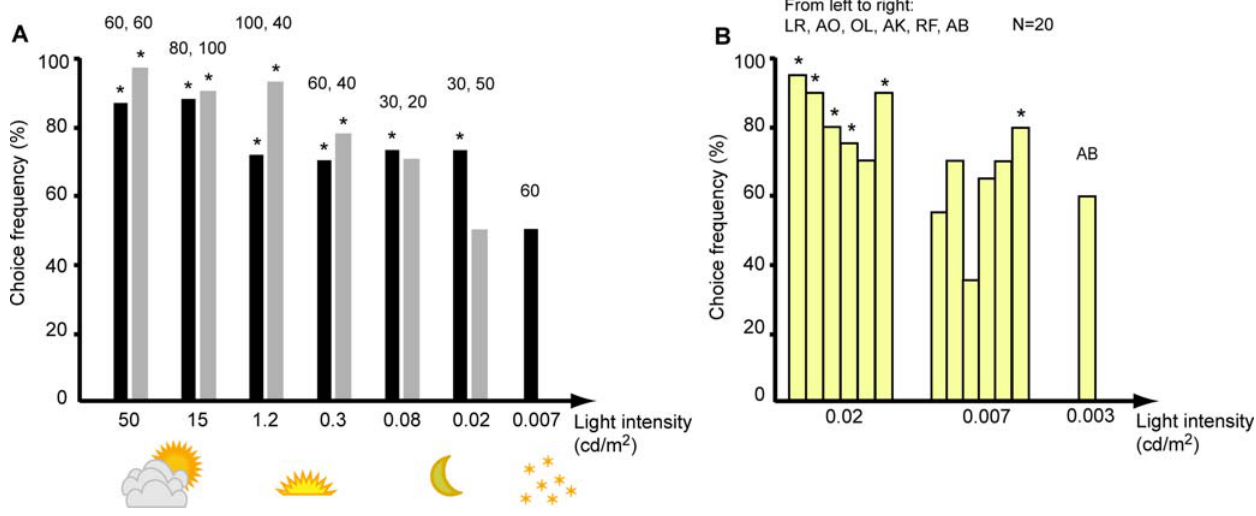
Figure 3. The choice frequencies at different light intensities for two horses (A) and six human subjects (B) as a comparison (binominal tests *P , 0.05). The data presented for Chap (black bars) and Rosett (grey bars) start from the second day they performed at least 70% correct choices and the number of choices are written above each bar. Chap discriminated colours at 0.02 cd/m 2 but chose randomly at 0.007 cd/m 2 . Six human subjects (B) were presented with 20 combinations per intensity. Initials of the human subjects are listed from left to right as they appear in the graph. All but RF chose the positive stimulus significantly more often at 0.02 cd/m 2 . At 0.007 cd/m 2 all but AB failed to discriminate the colours. AB did not fail until the light intensity was lowered to 0.003 cd/m 2 .